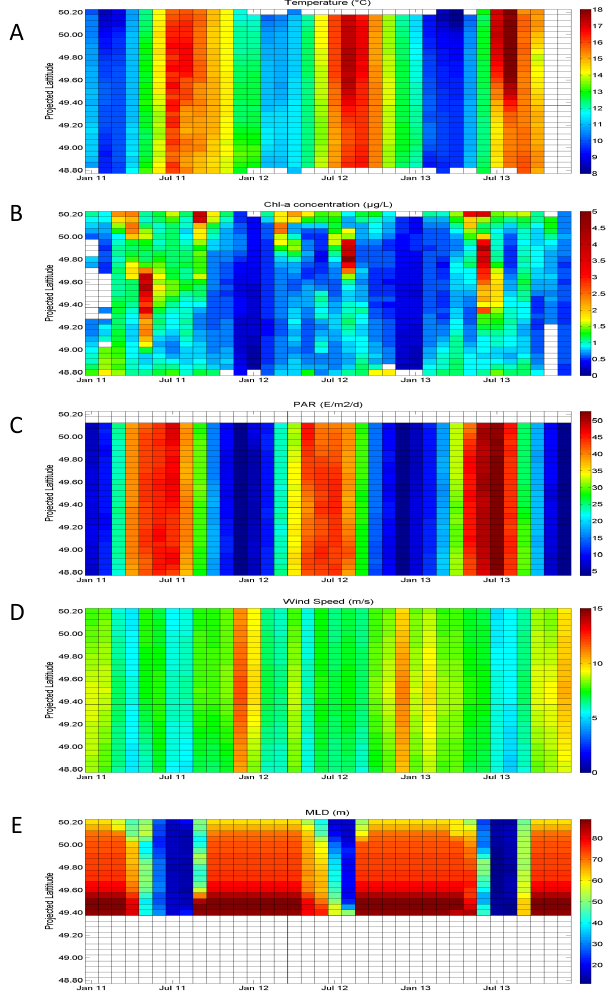
Figure 3. Distribution of monthly gridded (a) SST ( ◦ C), (b) Chl a (µgL − 1 ) , (c) PAR (Em − 2 d − 1 ) , (d) wind speed (ms − 1 ) and (e) MLD over depth ratio MLDr in the WEC between Roscoff and Plymouth from January 2011 to December